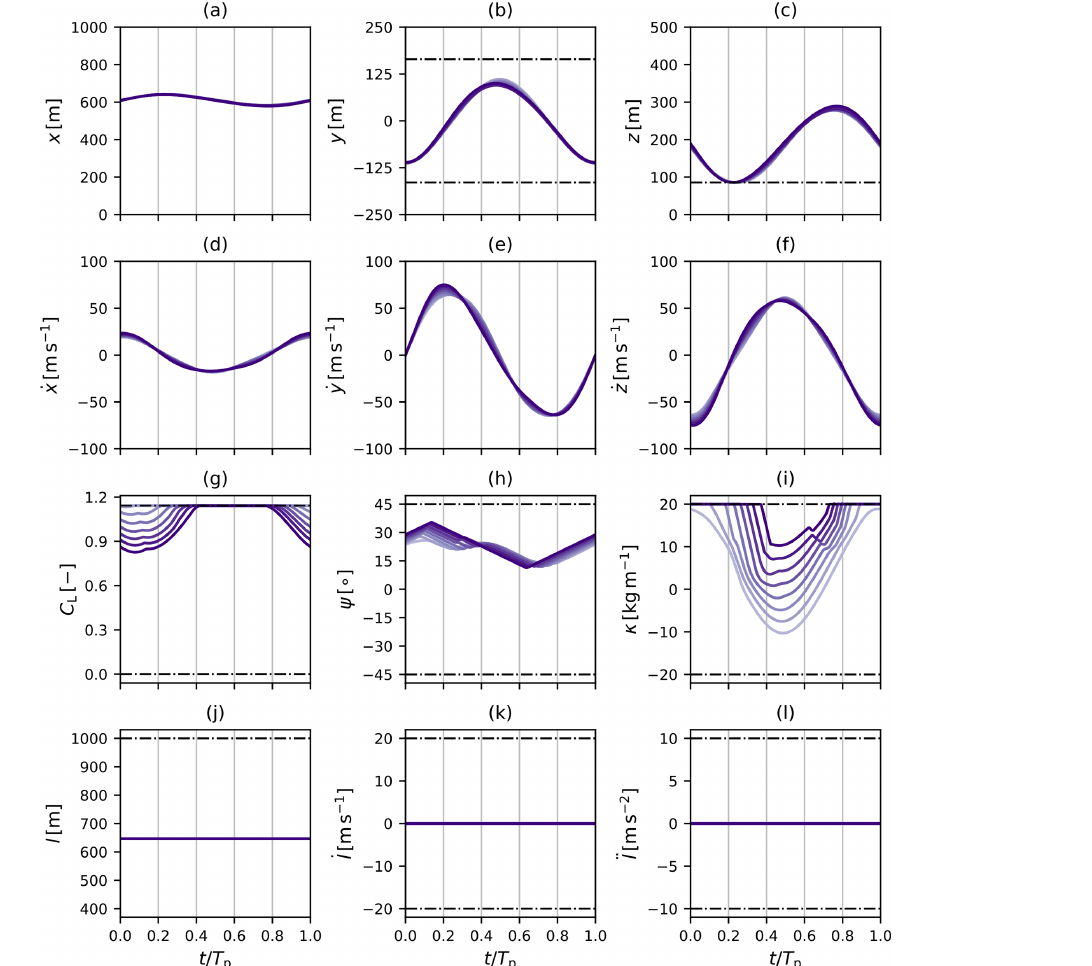
Figure B3. Time series of the states normalised over one period T p for the large-scale drag-mode AWE system optimised for the wind speed range U D = [ 5 . 0 , 12 . 0 ] . The position q and velocity ˙ q are respectively shown in (a–c) and (d–f) . The wing lift coefficient C L , roll angle (cid:57) , and on-board turbine thrust coefficient κ are shown in (g–i) . The tether variables l , ˙ l , and ¨ l , representing the length, speed, and acceleration of the tether, are shown in (j–l) . The colour scheme is identical to Fig. 3, and the black dashed lines represent the eventual constraints applied to the variables in POCP (Eq.